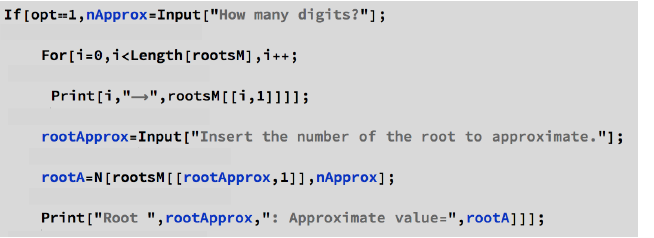
Figure 30. Part of the code structure of the [ARoots] algorithm code corresponding to the computation of an approximate value of a desired root. Figure 31 contains the flowchart of the [ARoots] algorithm.